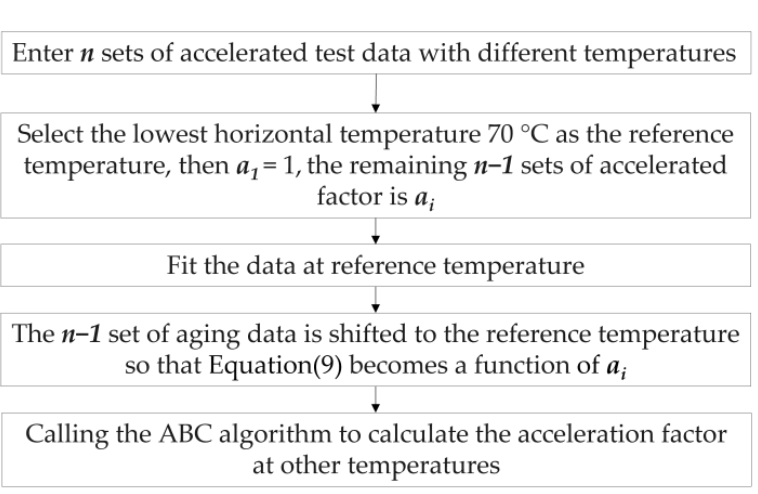
Figure 2. Steps to accelerate factor identification.